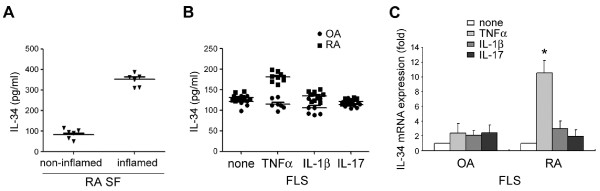
Effect of tumor necrosis factor alpha (TNFα) on the expression of interleukin-34 (IL-34) in rheumatoid arthritis (RA) and osteoarthritis (OA) fibroblast-like synovial cells (FLS). (A) Paired samples of non-inflamed (n = 7) and inflamed (n = 7) synovial fluid (SF) from individual RA patients were collected and analyzed for IL-34 by an enzyme-linked immunosorbent assay (ELISA). Closed triangles indicate individual data points; horizontal bars show group means (P < 0.01, inflamed versus non-inflamed RA SF samples). (B) Fibroblast-like synovial cells (FLS) were prepared and cultured as described in Materials and Methods. RA FLS (n = 9) and OA FLS (n = 7) were cultured with different cytokines (10 ng/ml of TNFα, IL-1β, or IL-17) for 24 hours, and the concentration of IL-34 in the media was measured by ELISA. Closed squares or circles indicate individual RA or OA data points, respectively; horizontal bars show group means (P < 0.01, IL-34 concentration in RA versus OA after TNFα treatment). (C) OA and RA FLS were treated with different cytokines (10 ng/ml of TNFα, IL-1β, or IL-17) for 24 hours. IL-34 mRNA levels in cell lysates were determined by quantitative reverse transcriptase-PCR (qRT-PCR). The relative expression of IL-34 mRNA was obtained using the cycle threshold (Ct) method after normalization to glyceraldehyde 3-phosphate dehydrogenase (GAPDH). Data are presented as fold-change of gene expression compared to untreated controls. Bars indicate the mean and SD of IL-34 mRNA expression relative to that of GAPDH (*P < 0.05, N.S., not significant, compared to none treated).